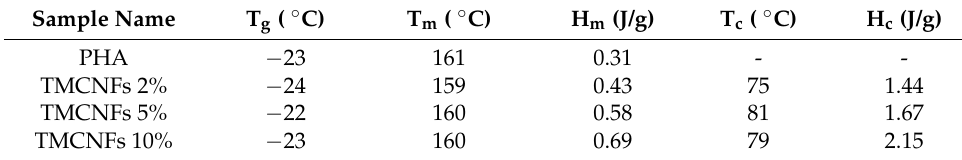
Table 2. Summarized thermal properties of the PHA–TMCNFs